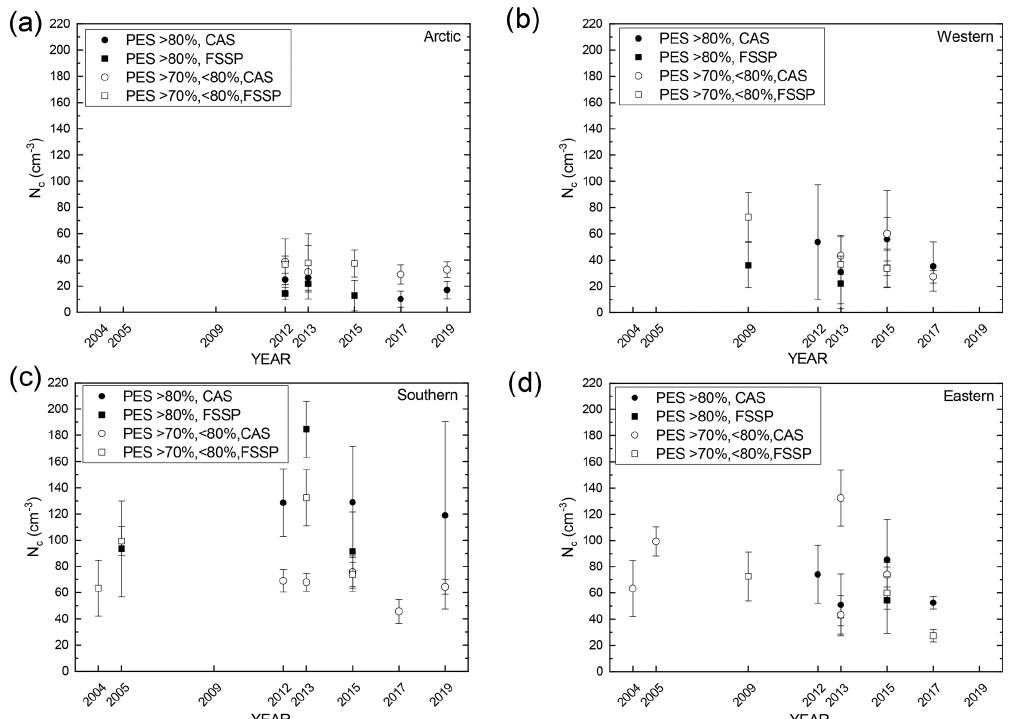
https://doi.org/10.5194/acp-23-2483-2023 Atmos. Chem. Phys., 23, 2483–2498,